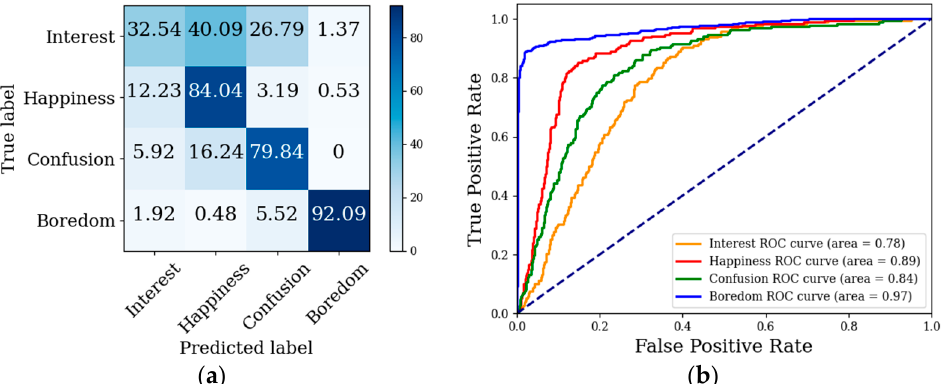
Figure 11. Confusion matrix and ROC curve for feature-level fusion model: ( a ) confusion matrix, ( b ) ROC curve of decision-level fusion.